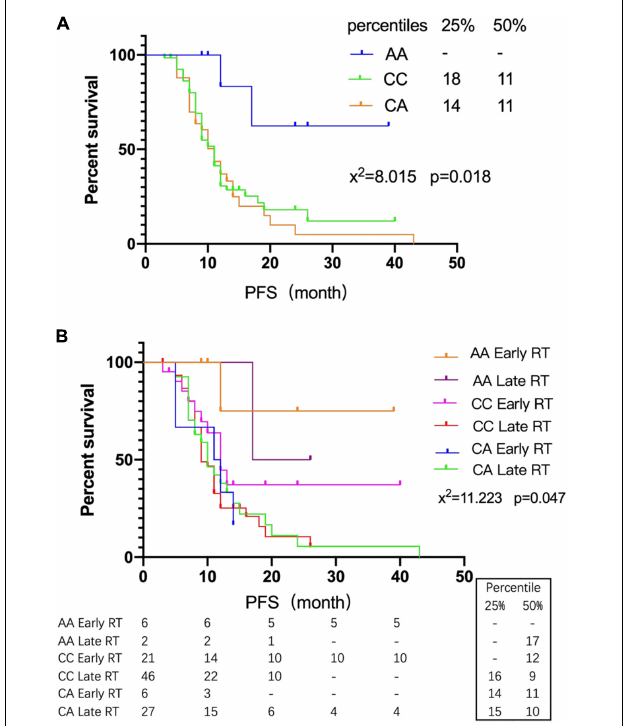
FIGURE 3 | The relationship between rs2299939 SNPs and early or late radiotherapy. (A) Survival curves of different genotypes of rs2299939 and PFS. (B) Survival curves of different genotypes of rs2299939 with various radiotherapy intervening times and PFS.